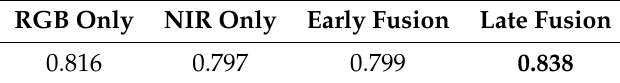
Table 2. F1 scores of fused and single-stream